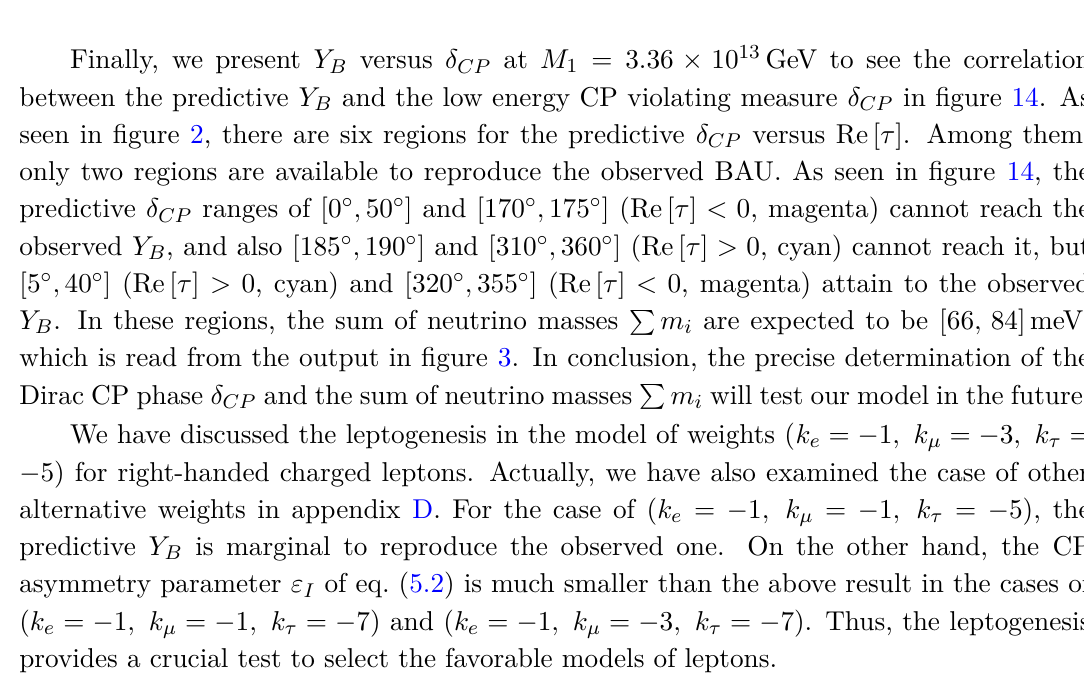
Figure 13 . Predictive Y B versus the mass ra- tio M 2 /M 1 at M 1 = 3 . 36 × 10 13 GeV. Points correspond to the low energy output of sec- p tion 4 at χ 2 ≤ 3 , where cyan and magenta correspond to positive and negative Re [ τ ] , re- spectively. Horizontal dashed line denotes the central value of observed Y B .